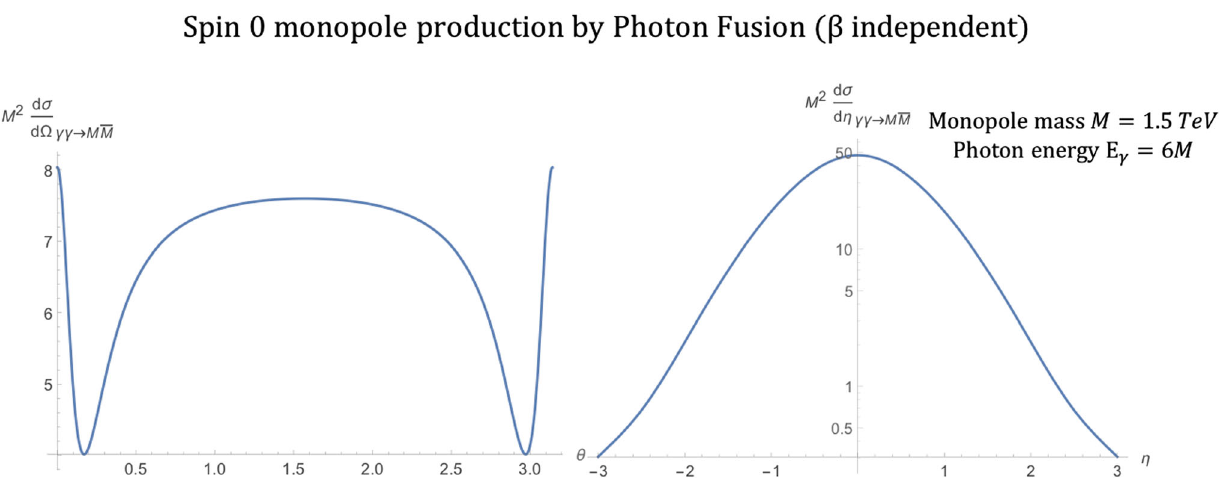
√ s γγ = 2 E γ , where